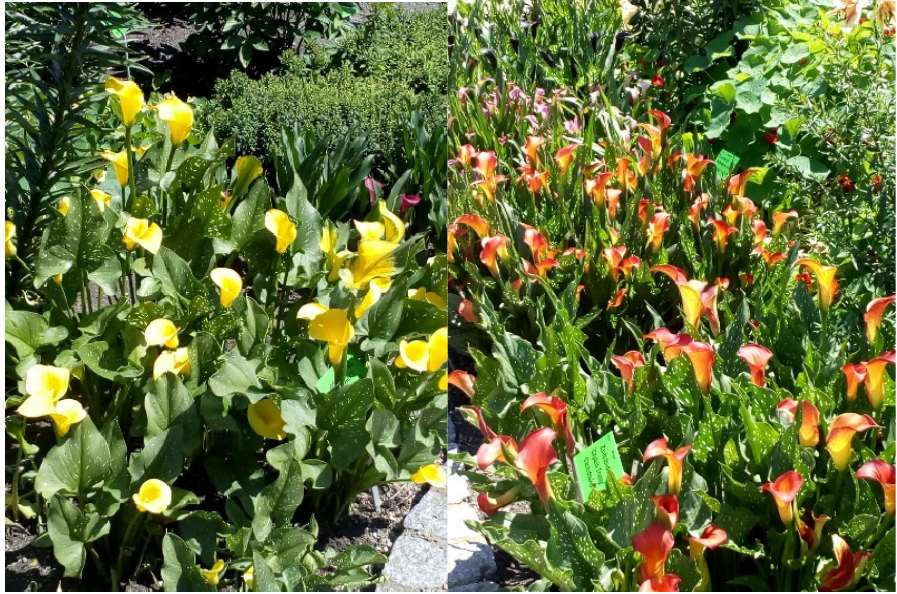
Figure 3. Zantedeschia cultivars in the botanical garden in Wroc ł aw (Beata Janowska 2017).